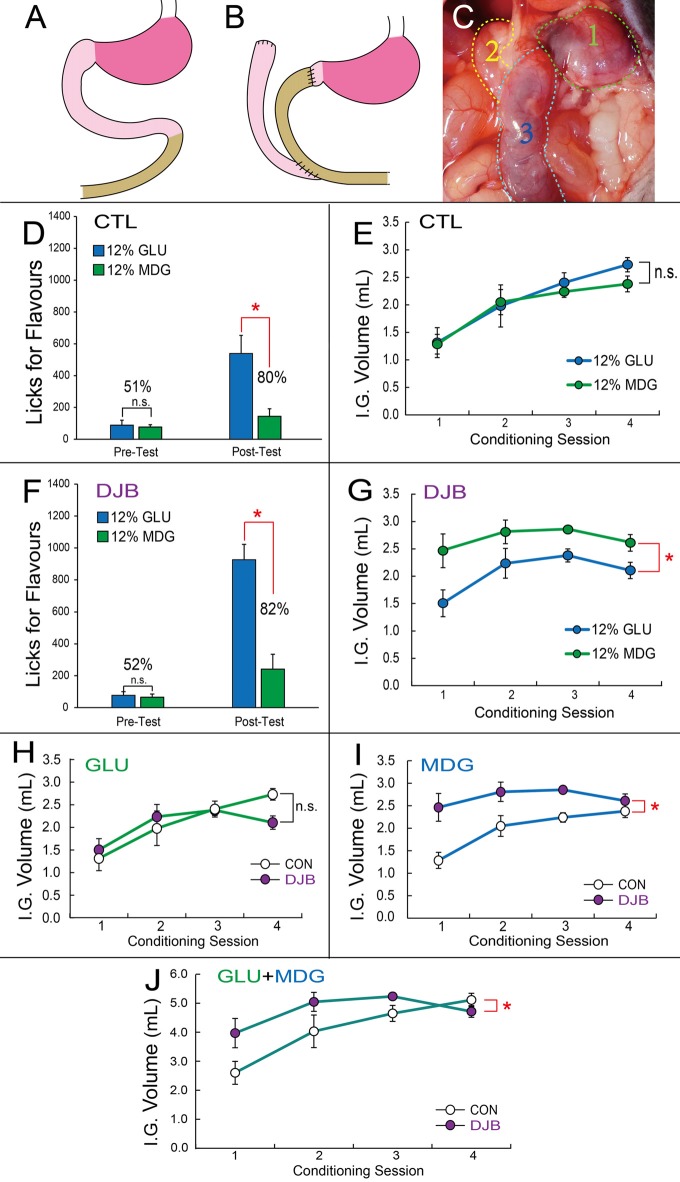
Duodenum jejunum bypass (DJB) mice displayed greater preferences for flavors associated with metabolizable glucose, despite showing decreased satiety for non-metabolizable glucose. (A,B) Schematic representation of the DJB intervention, which includes duodenal segmentectomy, jejunal-pylorus end-to-end anastomose and duodenal-jejunal end-to-side anastomose. (C) A blue dye was infused through a gastric catheter for assessment of surgical efficacy. In DJB mice the dye was visible only in stomach and jejunum. Legend: (1) Stomach; (2) Duodenum; (3) Distal jejunum. (D) In the sham control group, short-term two-bottle preference tests performed before conditioning sessions (left bars) reveal no differences between number of licks produced for the 12% GLU-associated vs. 12% MDG-associated flavor (post hoc paired t-test, N = 5, p = 0.8), resulting in preferences of 51% for the 12% GLU-associated flavor. However, after conditioning sessions (right bars), a significant increase in the number of licks for the 12% GLU-associated flavor (*p = 0.016) was observed, resulting in a preference of 80% for the 12% GLU-associated flavor. (E) Number of gut infusions produced throughout the conditioning sessions revealed no major differences between infused volumes of each sugar (two-way ANOVA conditioning session × sugar, p = 0.49). (F) In the DJB group no differences between number of licks produced for the 12% GLU-associated vs. 12% MDG-associated flavor were observed before conditioning sessions (left bars, post hoc paired t-test, N = 5, p = 0.7), resulting in preferences of 52% for the 12% GLU-associated flavor. However, after conditioning sessions (right bars), a significant increase in the number of licks for the 12% GLU-associated flavor (*p = 0.004) was observed, resulting in a preference of 82%. (G) In the DJB group, number of gut infusions produced throughout the conditioning sessions revealed that 12% MDG was infused at higher volumes than glucose (sugar effect, F(1,5) = 13.7, *p = 0.014). (H) DJB and control groups self-infused similar amounts of 12% GLU throughout the conditioning sessions (two-way RM-ANOVA p = 0.067). (I) In the DJB group, number of gut infusions for MDG produced throughout the conditioning sessions was greater than in the control group (two-way ANOVA conditioning session × sugar, F(3,30) = 6.887, *p = 0.001). (J) The total volume of 12% GLU and 12% MDG gut infusions produced throughout the conditioning sessions revealed overall higher volumes in DJB compared to control mice (two-way ANOVA conditioning session × sugar, F(3,30) = 3.921, *p = 0.018). IG, Intra-Gastric infusion; ns, non-statistically significant. Data depicted as mean ± SEM across animals in all figures.